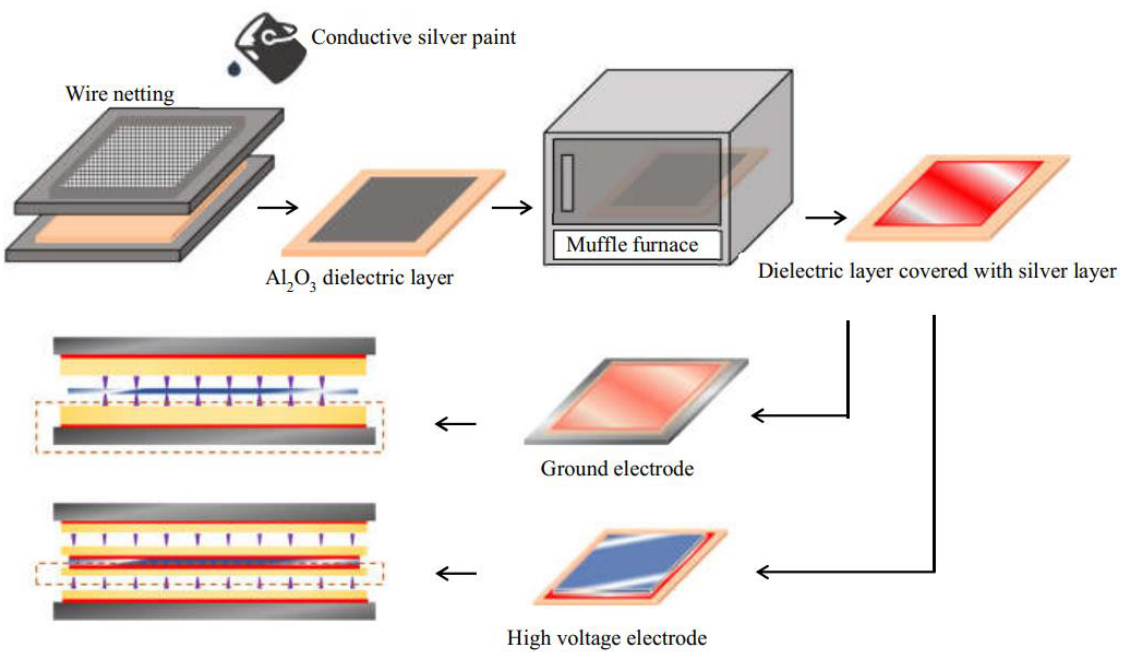
Figure 3. Fabrication of dielectric layer covered with silver layer.